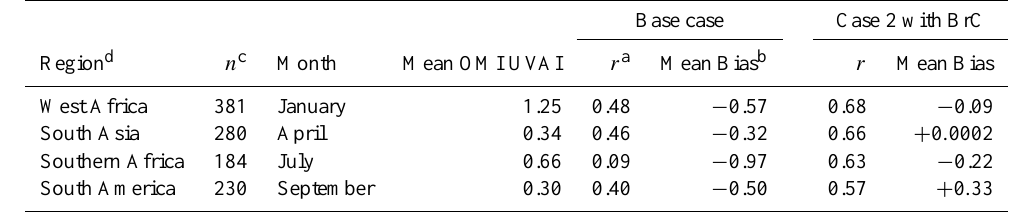
Table 4. The mean AOD values for each region from the GEOS-Chem (GC) base case simulation, the MISR instrument, and the MODIS Terra satellite instrument. The MODIS values are included for both the collection 6 Deep Blue and Dark Target algorithms. Mean AOD Region ∗ GC MISR MODIS Deep Blue MODIS Dark Target West Africa 0.42 0.42 0.45 0.51 South Asia 0.32 0.32 0.30 0.37 Southern Africa 0.19 0.19 0.13 0.24 South America 0.31 0.36 0.39 0.57 ∗ Regions are defined in Fig.